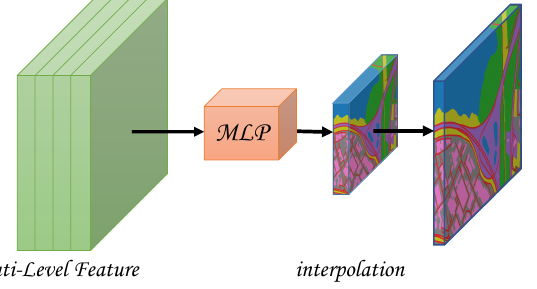
Figure 8. Segmentation Module. The MLP layer includes a fully connected layer for features of different scales and a convolution layer for features of different scales